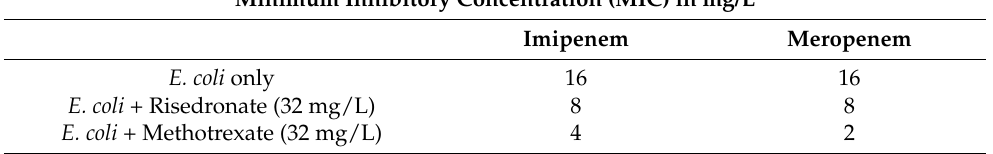
Table 5. MICs of an E. coli (ATCC-BAA-2469) strain carrying the bla NDM-1 gene towards imipenem and meropenem in the presence of risedronate and